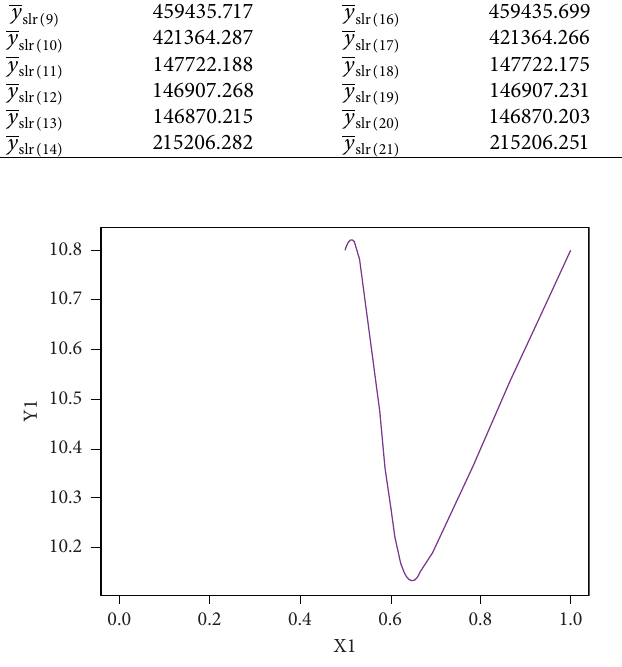
Figure 5: Stratum-I